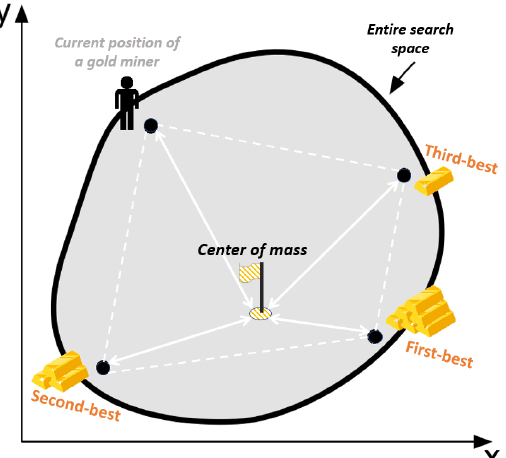
Figure 1. Determination of the next position based on the values of a miner’s current position and the three best positions.